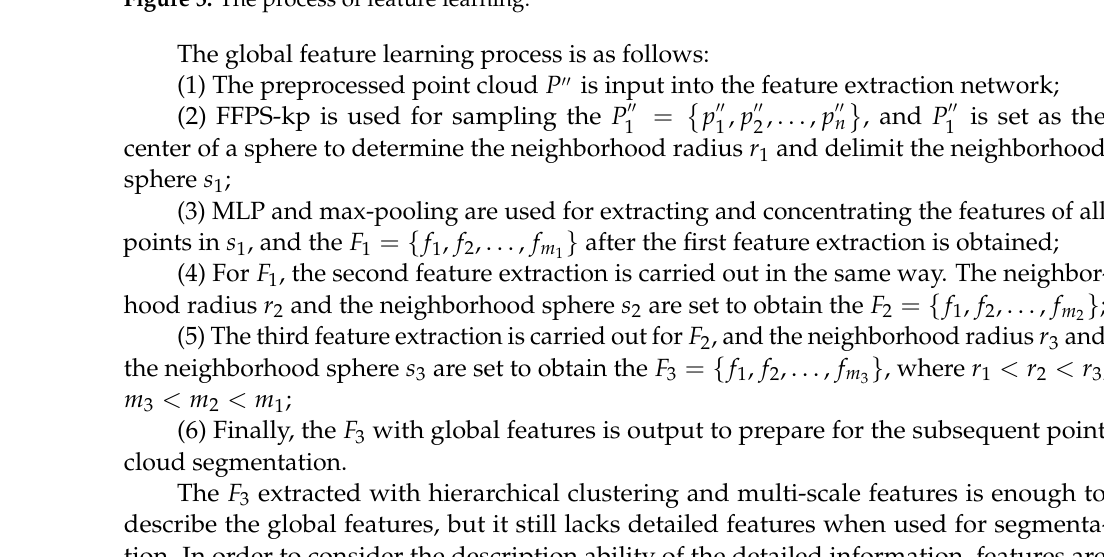
Figure 5. The process of feature learning.